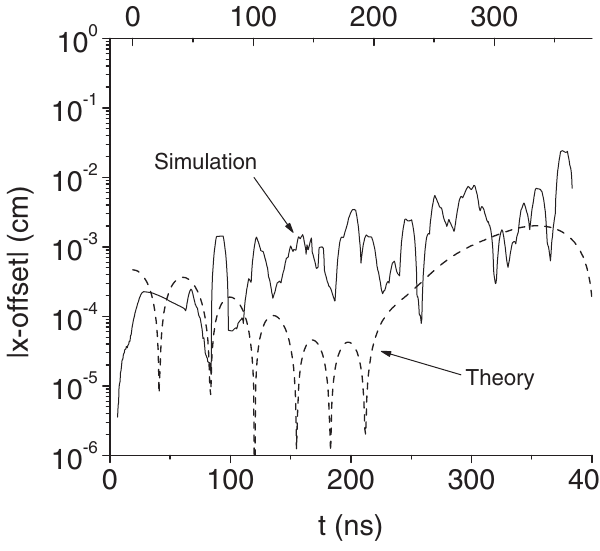
FIG. 12. Same as Fig. 10 except for a